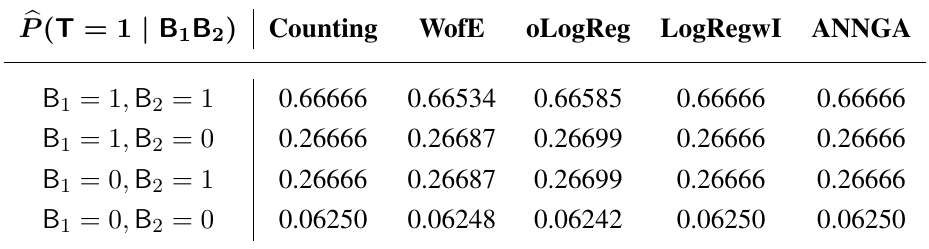
Table 9. Comparison of conditional probabilities predicted with elementary counting, weights-of-evidence (WofE), ordinary logistic regression without interaction terms (oLogReg), logistic regression including interaction terms (LogRegwI), and artificial neural nets using a genetic algorithm (ANNGA [38]) applied to the training dataset DFQR .